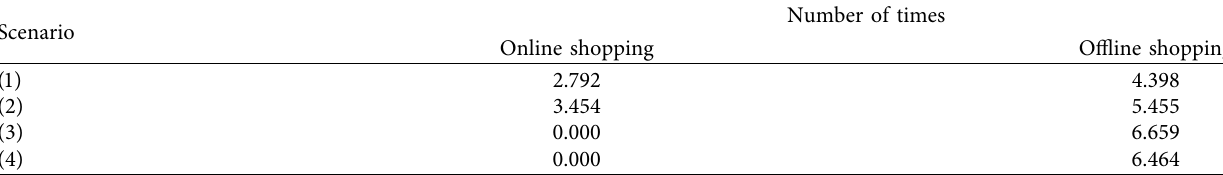
Table 6: Predicted number of shopping sessions (unit: sessions/person/month).